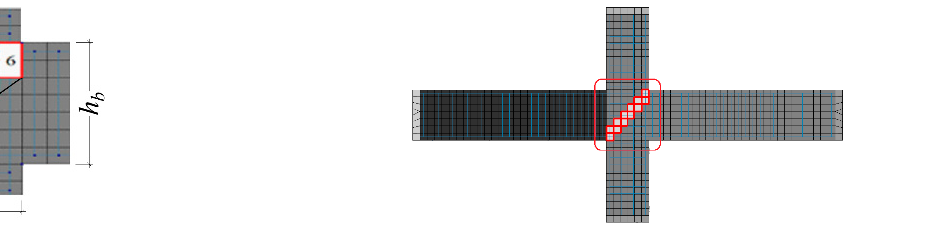
Figure 15. Diagonal elements of the joint panel in the finite element (FE) models.